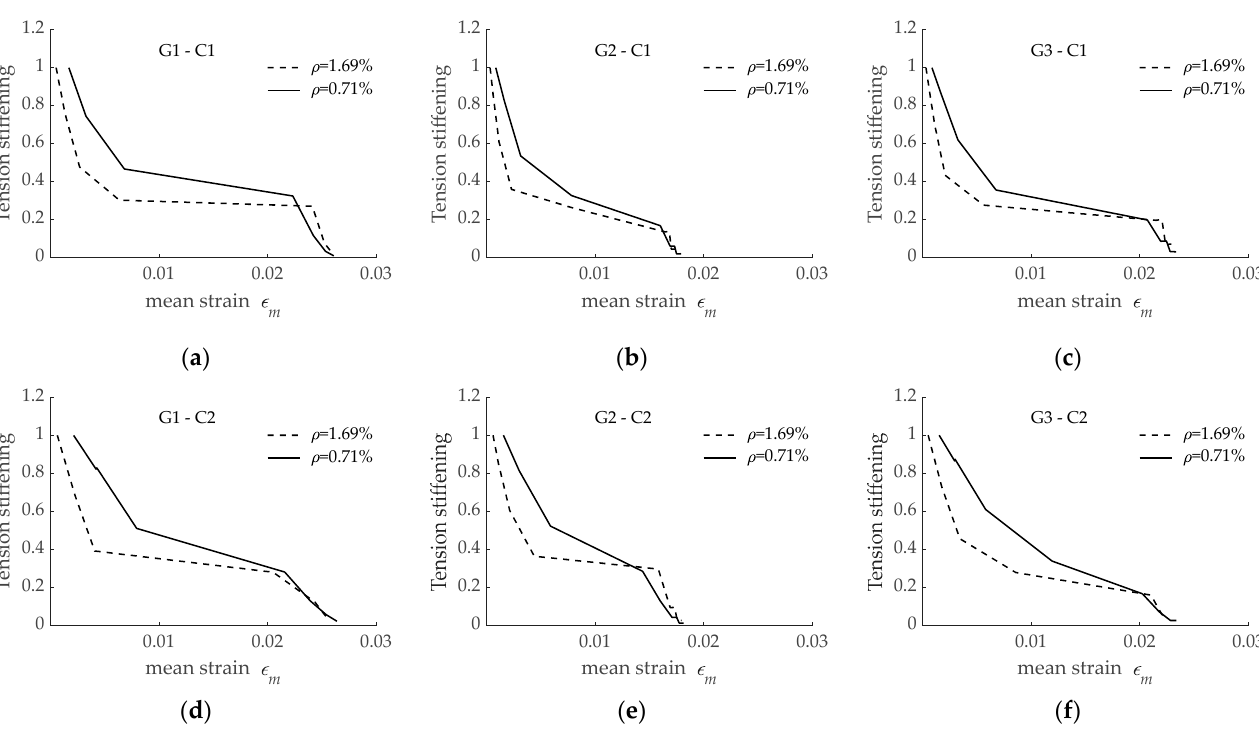
Figure 15. Effect of concrete compressive strength on tension stiffening effect for RC tensile elements